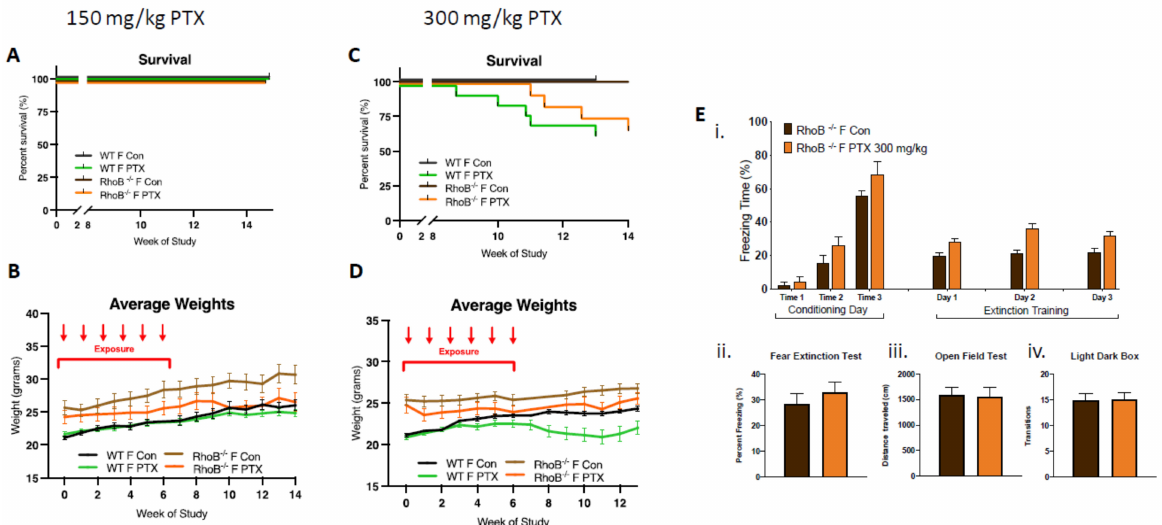
Figure 3. rhoB deficiency does not impact systemic toxicity or neurotoxicity in females treated with paclitaxel. ( A ) After 150 mg/kg paclitaxel treatment, survival curves showed no mortality in either WT ( n = 18) or rhoB- deficient females ( n = 12) as compared with control mice (WT + rhoB –/– n = 21). ( B ) rhoB- deficient females showed no weight uptake as compared with control untreated rhoB- deficient females, whereas WT treated and untreated mice showed similar weight uptake. Three-way ANOVA of weights found significant variation between female rhoB –/– and WT genotypes ( p < 0.0001), paclitaxel treatments ( p < 0.0001), and genotypes × treatments ( p < 0.0001) over 14 weeks. Chart uses mean ± s.e.m. ( C ) After 300 mg/kg paclitaxel treatment, survival curves show 36% mortality in WT ( n = 14) and 25% mortality in rhoB- deficient females ( n = 12) 13 weeks post-paclitaxel. Comparison survival curves demonstrate significant difference ( p < 0.0001) in log-rank (Mantel–Cox) test. ( D ) WT females showed less weight uptake from treatment. Three-way ANOVA of weights found significant variation due to treatment ( p < 0.0001) and genotype ( p < 0.0001). ( E ) 300 mg/kg paclitaxel administration, ( i ) acquisition of conditioned fear (three tone-shock pairings) was not impaired in rhoB- deficient female and mice did not exhibit decreased freezing behavior over extinction sessions (tone only) ( n = 8). ( ii – iv ) No significant difference in fear extinction ( n = 8), mobility (control n = 12, treated n = 12), or anxiety (control n = 12, treated n = 12) behavior in rhoB- deficient females after 300 mg/kg paclitaxel was found (unpaired t